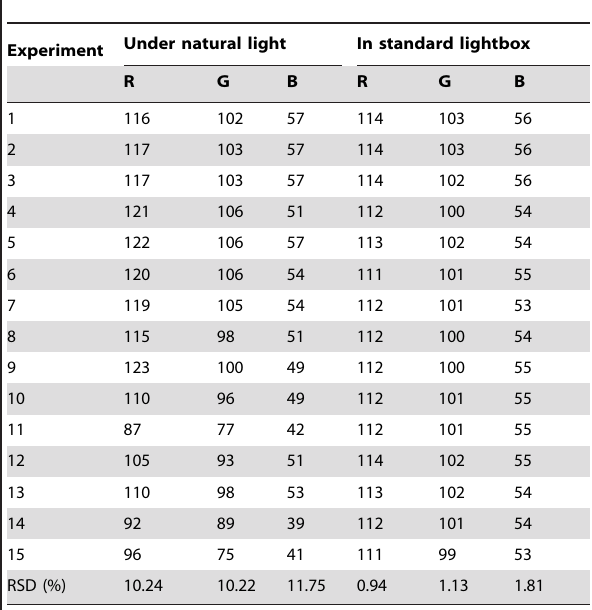
Table 2. The reproducibility of the RGB